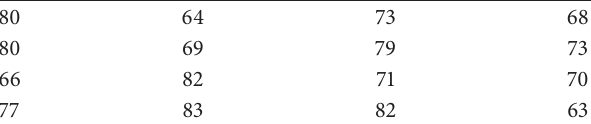
Table 2: Modified 4 × 4 block of the medical